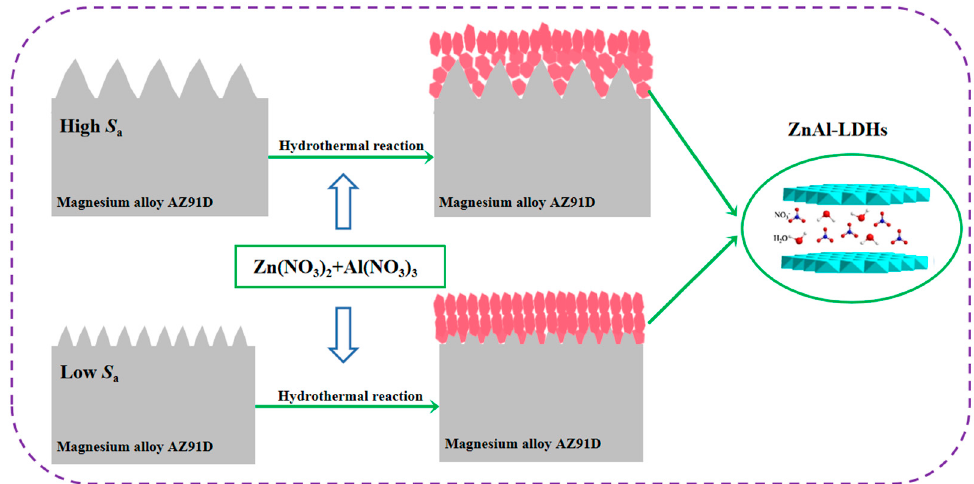
Figure 11. The mechanism of in situ growth of ZnAl-LDHs thin film on magnesium alloy surface .